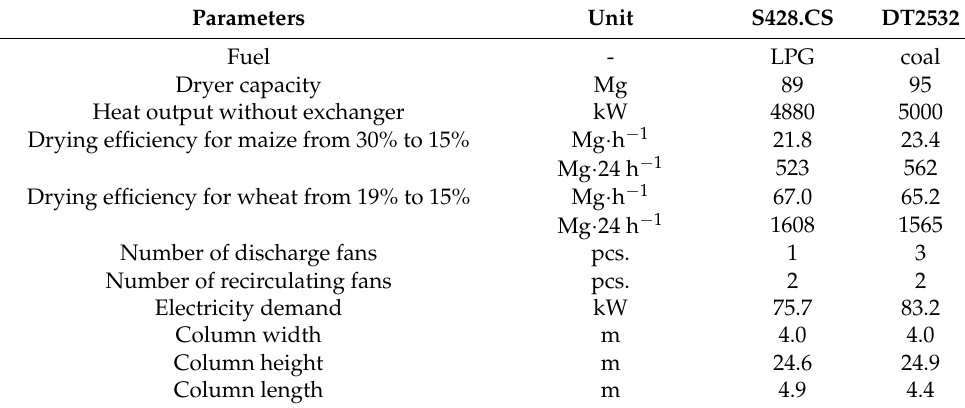
Number of recirculating